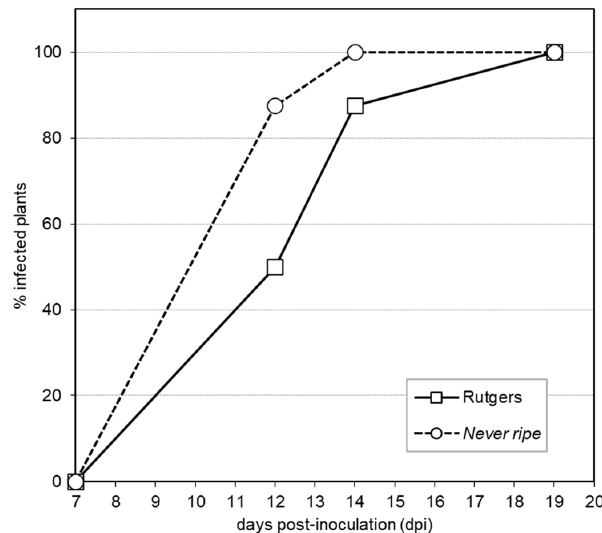
Figure 2. Disease development in Rutgers and Never ripe ( Nr ) plants infected with CEVd. Evolution of the percentage of tomato plants showing symptoms at the indicated days post inoculation (dpi). Data displayed correspond to one representative experiment.